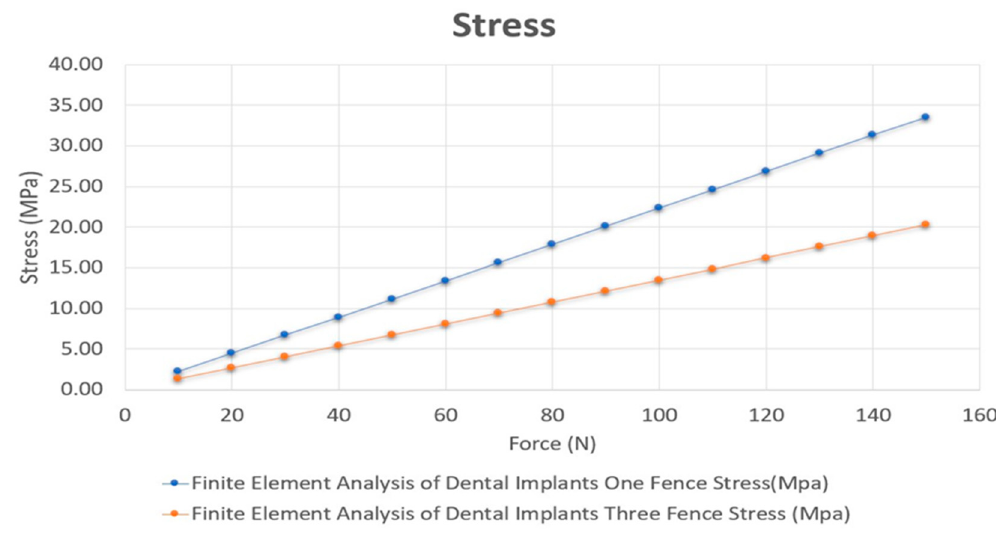
Figure 4. Deformation analysis of the two designs at various loads.